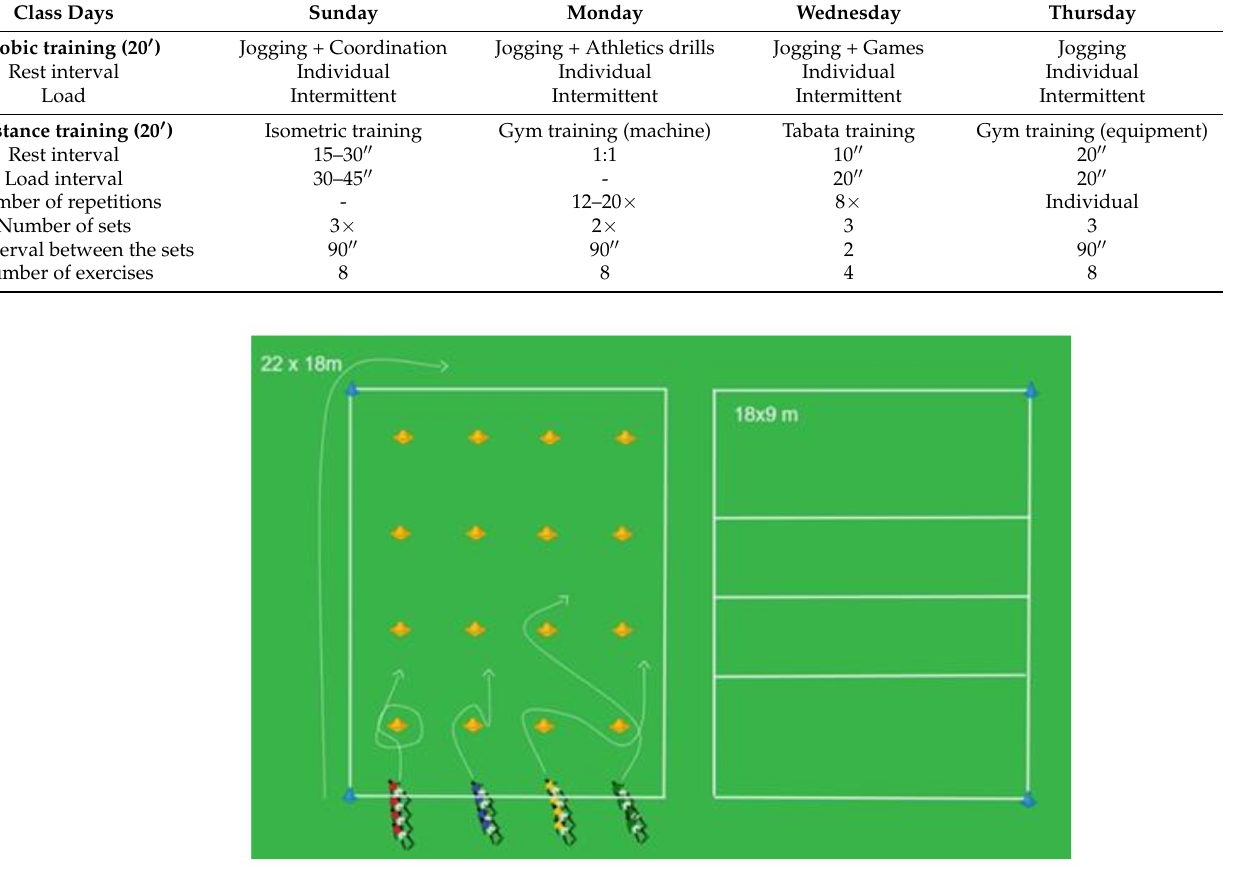
Figure 1. The aerobic